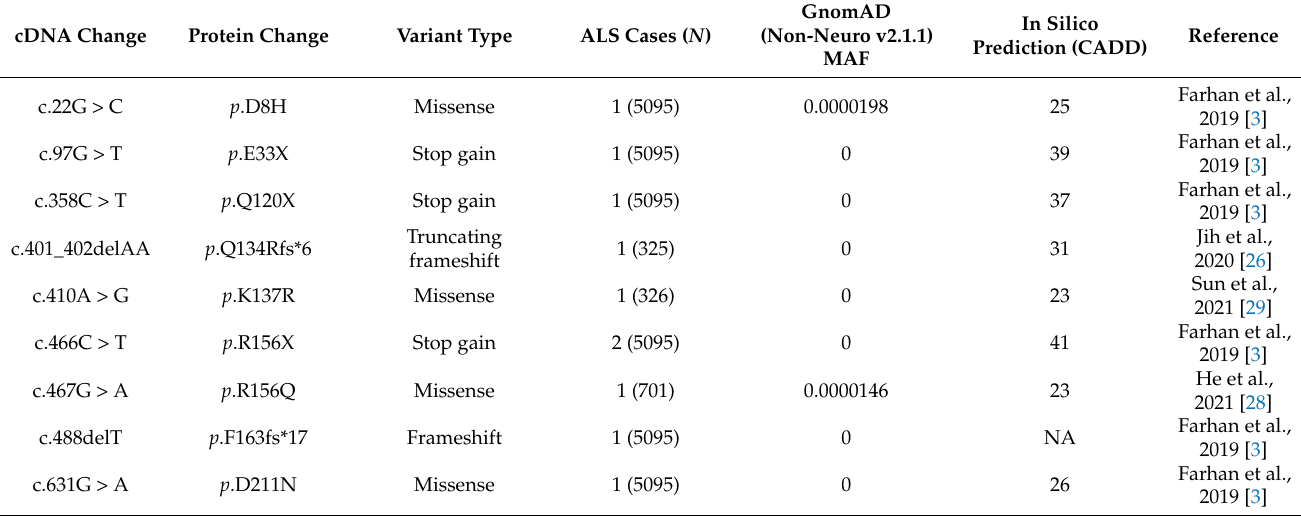
Table 2. Likely damaging variants previously identified in DNAJC7 in multiple ALS